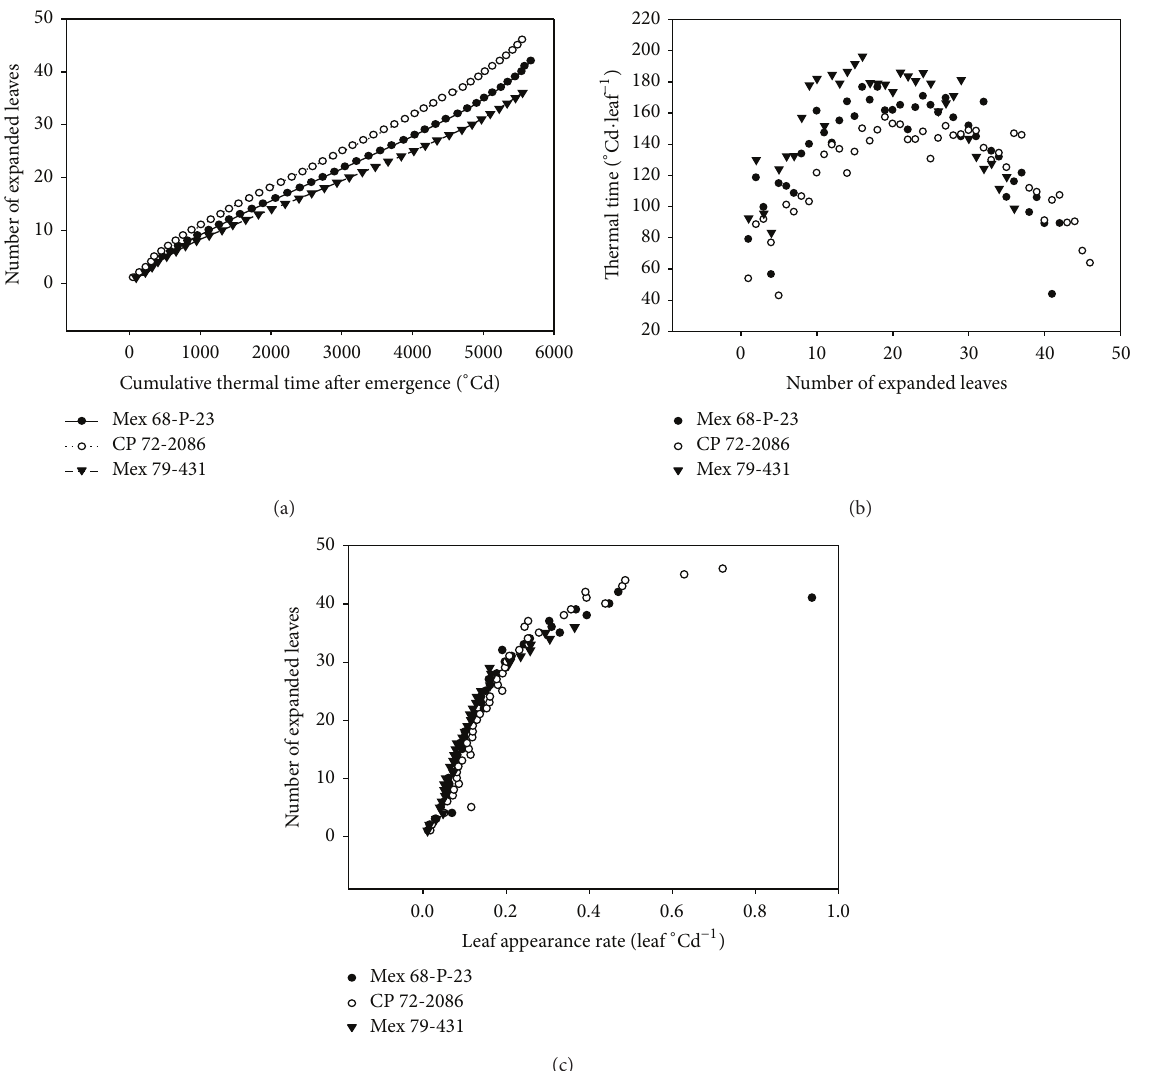
Figure 4: The progress of leaf area index with time for three sugarcane cultivars sown on the same date during the period of canopy closure to harvest under high temperature rainfed conditions in Northeastern